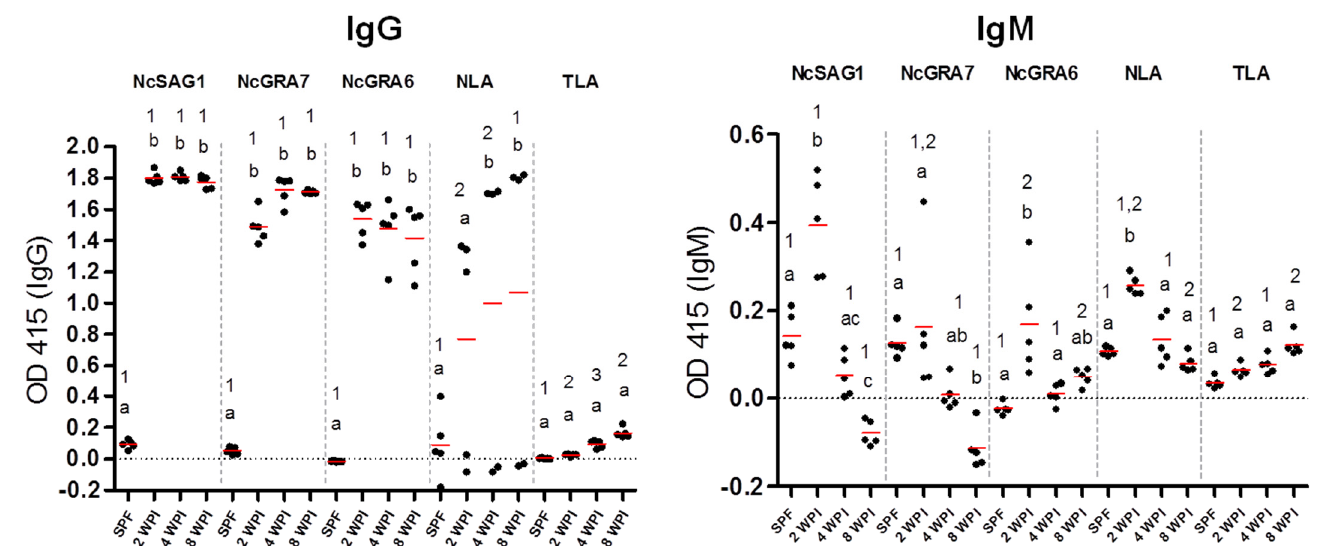
Figure 3. Reactivity of enzyme-linked immunosorbent assay (ELISA) against experimental mouse sera. Responses of recombinant and lysate antigens (NcSAG1, NcGRA7, NcGRA6, and NLA) were tested against mouse sera using the IgG-ELISA ( left panel) and IgM ELISA ( right panel). Sera from non-infected ( n = 5) and N. caninum -infected ( n = 5) for each type of sample representing 2, 4, and 8 weeks post-infection (wpi). Same samples were also tested against T. gondii lysate to exclude the cross-reactivity. Each bar represents the mean ± standard deviation ( n = 5 for all groups). The different letters above the bars in the graphs indicate statistically significant differences of different sera against the same tested antigen. The different numbers above the bars indicate the statistically significant differences for the same serum sample against different tested antigens (one-way ANOVA with Tukey–Kramer post hoc analysis, p < 0.05).